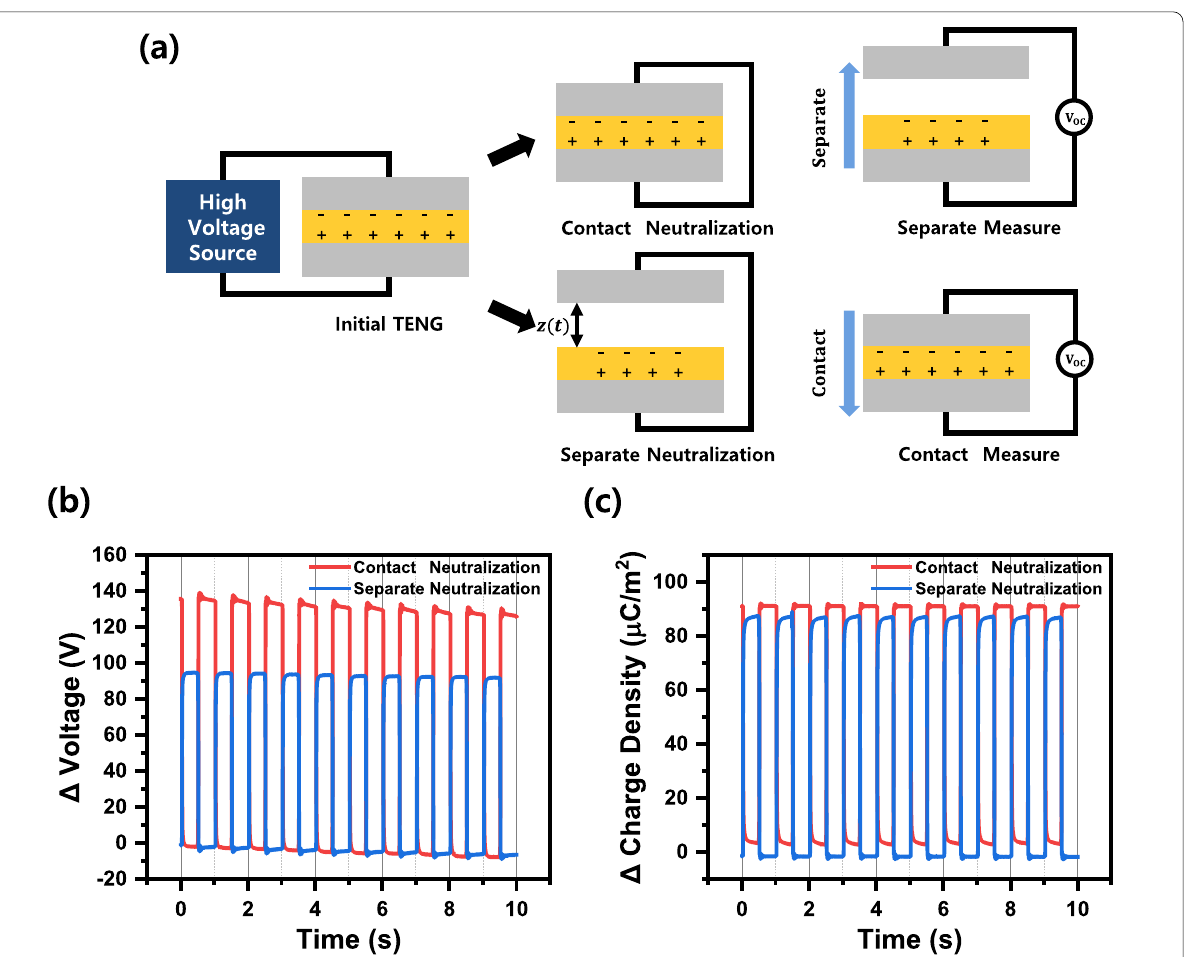
Fig. 2 a Two different electrode charge balancing for TENG output measurement, b output voltage, note the peak and bottom sequence depending on the charge balancing method, and c the charge density. For easy comparison, we take absolute values for the voltage and